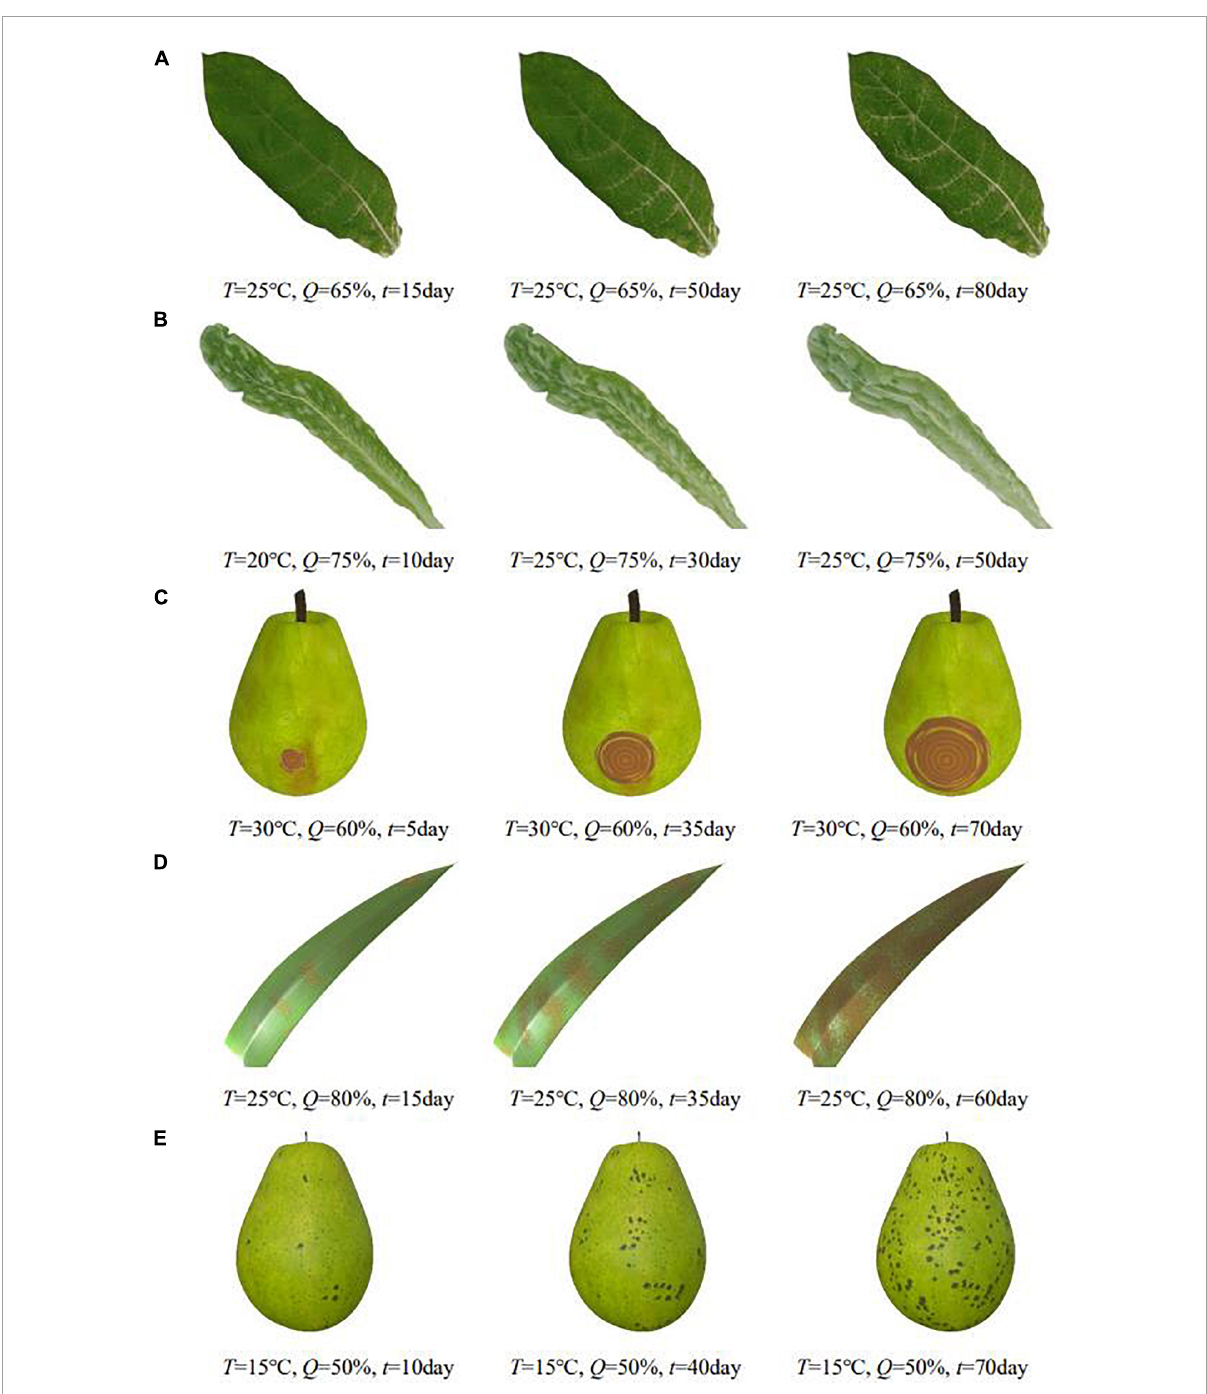
FIGURE10 Simulation results of other plant diseases under different parameters control. (A) Tobacco mosaic, (B) lettuce downy mildew, (C) pear ring rot, (D) corn rust, (E) pear scab.